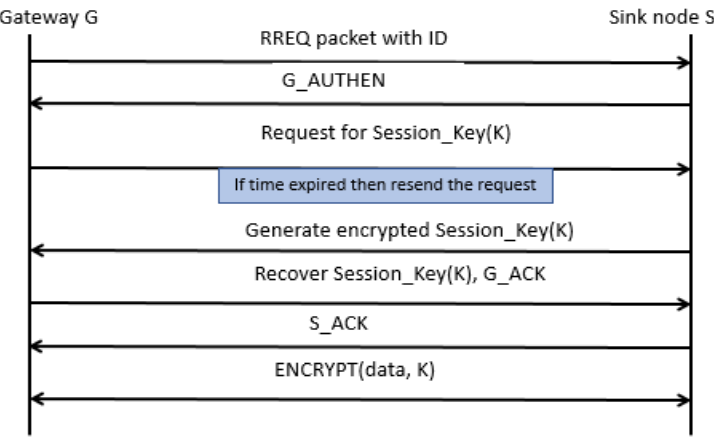
Figure 5. Message flow between the gateway and the sink node.